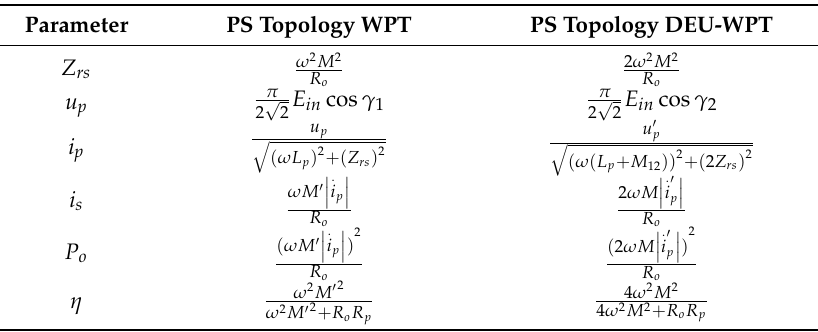
Table 1. Comparison between classical WPT and